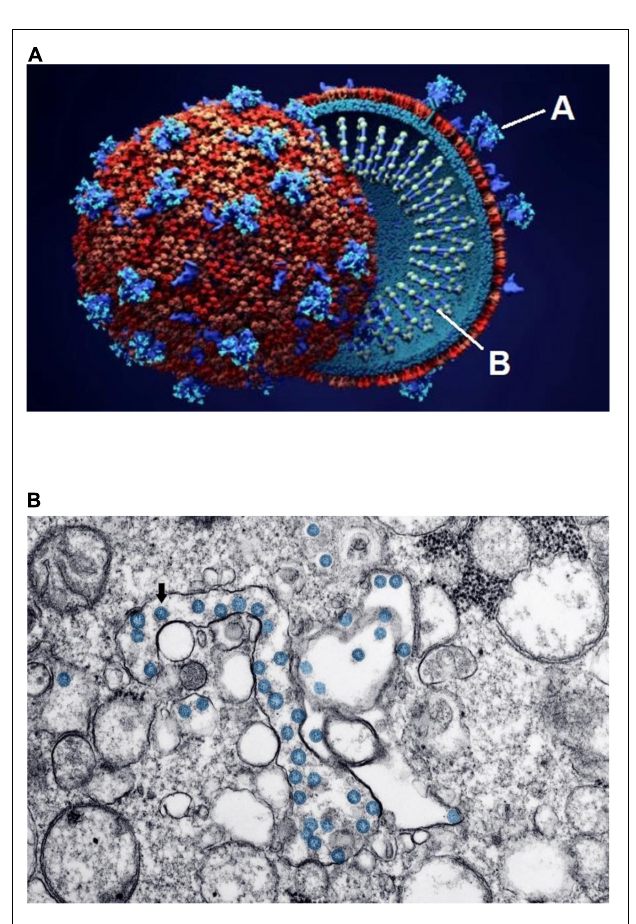
FIGURE 1 | Schematic structure and early invasion of the SARS-CoV-2 coronavirus. (A) This simplified outline of the viral unit shows its two essential components: “A” indicates the outer spikes (S protein, main antigen units) and “B” indicates the inner single-stranded RNA (the genetic viral genome). (B) Electron microscopy imaging showing coronavirus invasion (multiple round units, in blue) inside the pulmonary alveolar spaces and interstitial cells. Source: (A) Design Cells/Shutterstock and (B) Centers for Disease Control and Prevention, Public Health Image Library. ID# 23354; Hannah A. Bullock; Azaibi Tamin (2020);